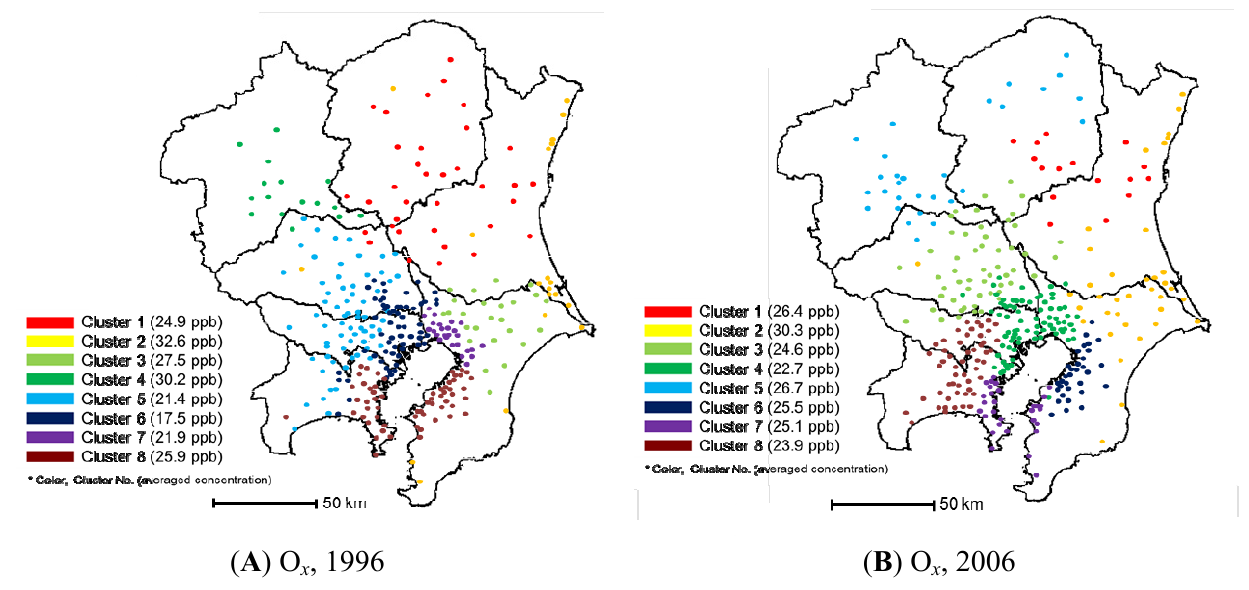
monitoring data: ( A ) in 1996 and ( B ) in 2006. x